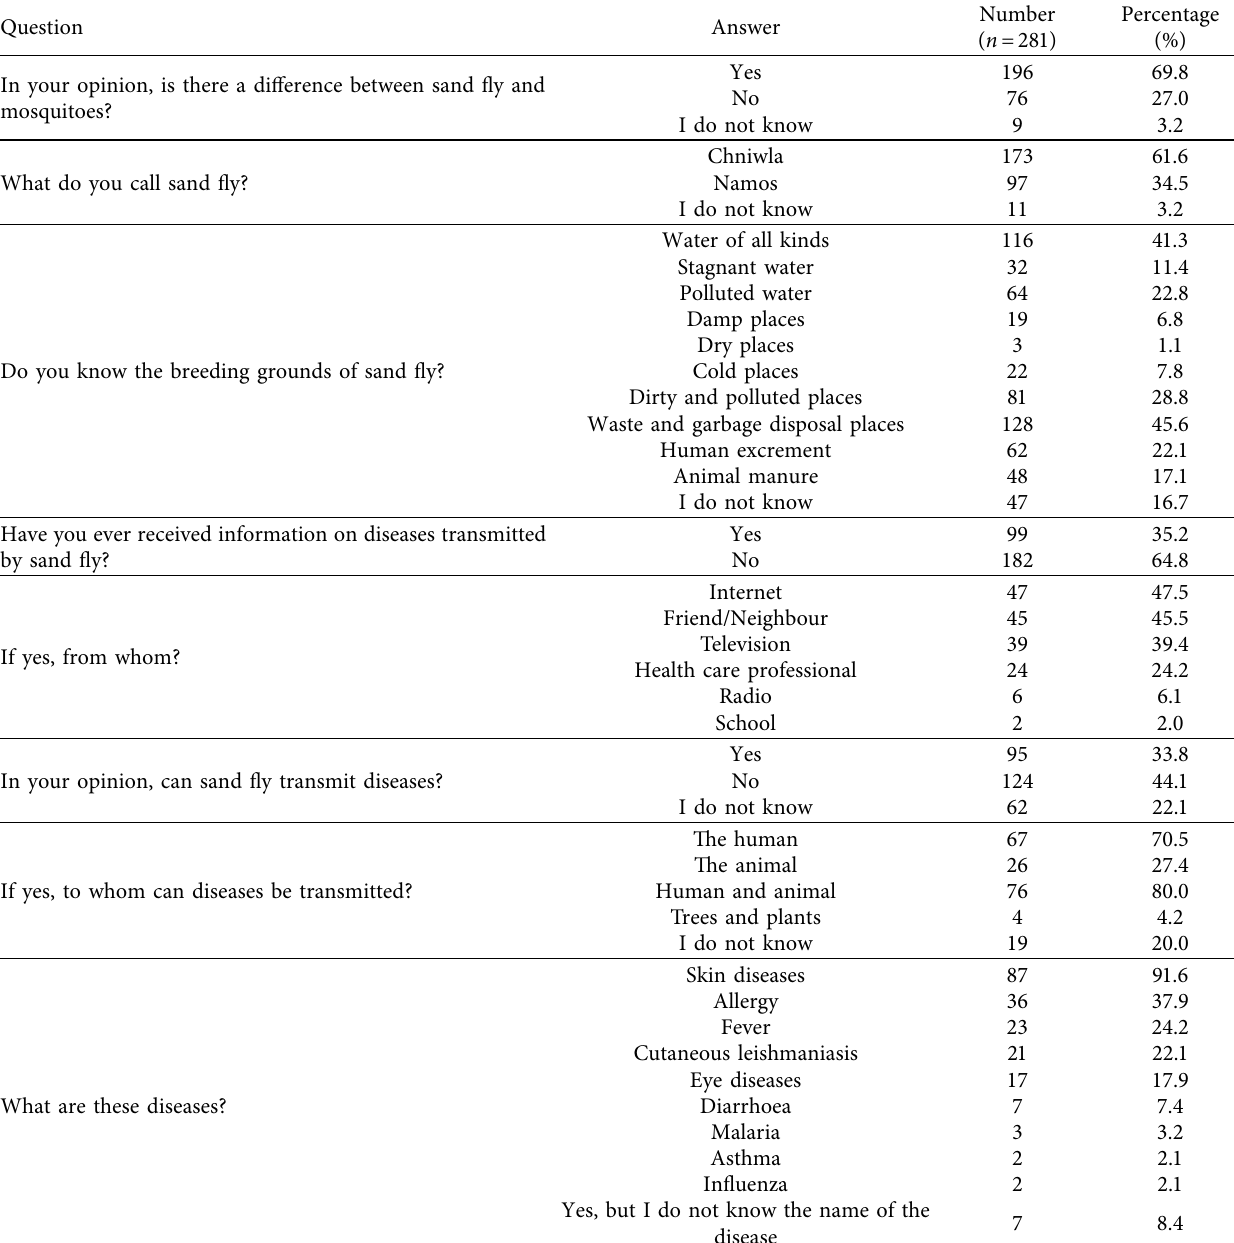
Table 4: Citizens’ knowledge and beliefs about the sand